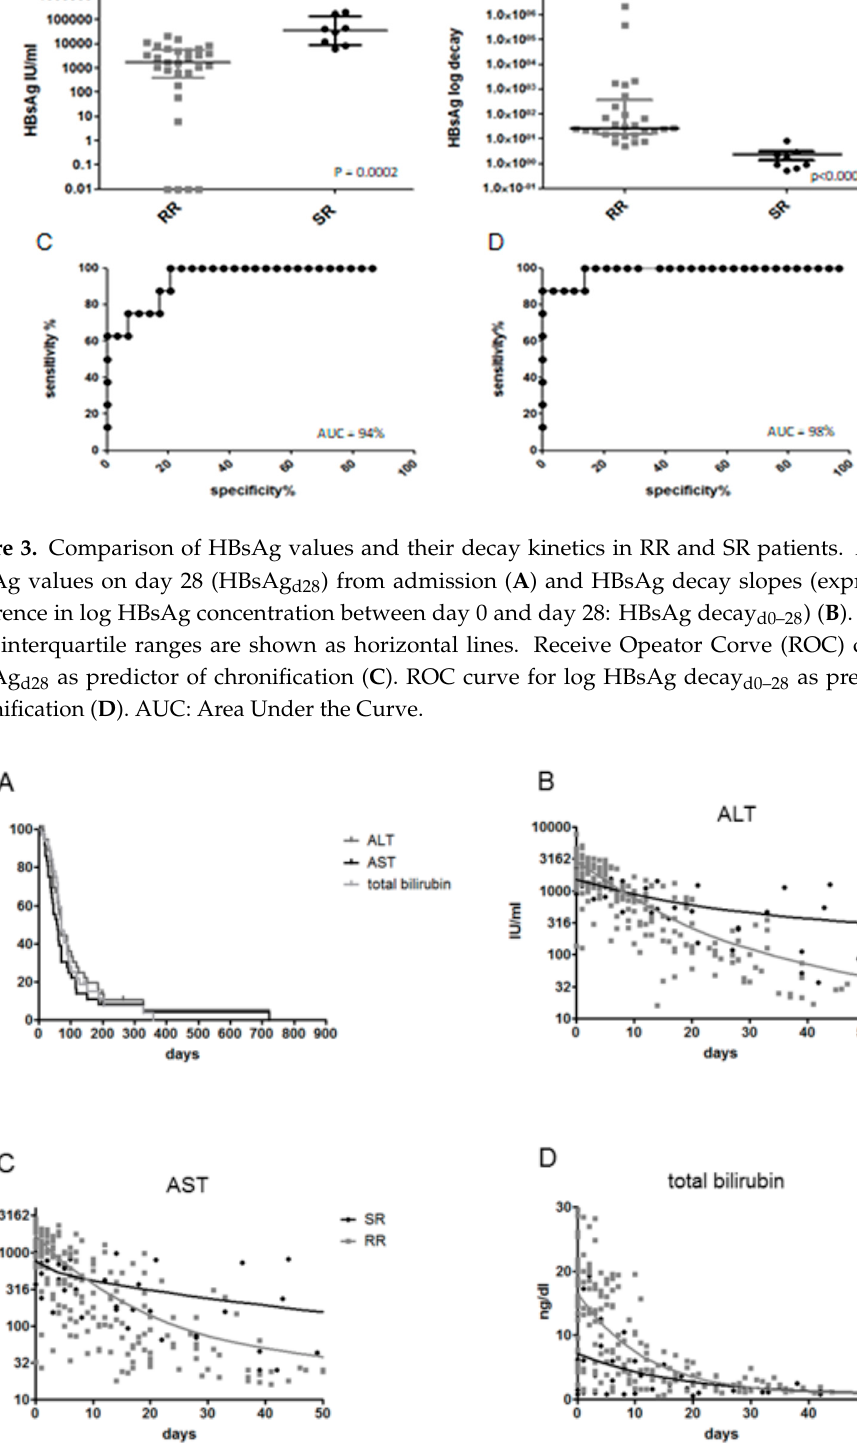
Figure 4. Analysis of the normalization of biochemical parameters. Kaplan Meier analysis of normalization ( A ) of ALT, AST, and total bilirubin in 44 AHB patients with long-term follow-up. Decay of biochemical parameters from the time of peak values. The values of ALT ( B ), AST ( C ), and total bilirubin ( D ) at different time points of patients with follow-up were grouped in scattergrams and the relative best fit-triphasic decay curves were calculated, respectively, for SR and RR.